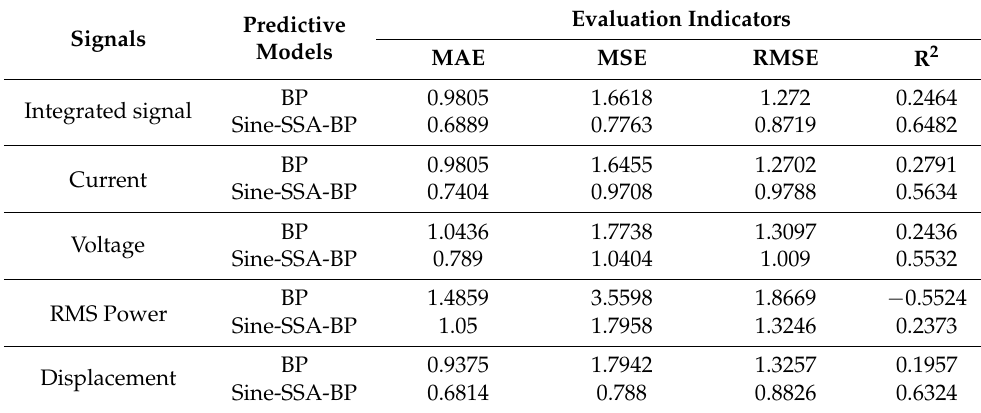
Table 4. Comparison of predictions of various signals by Sine-SSA-BP and BP